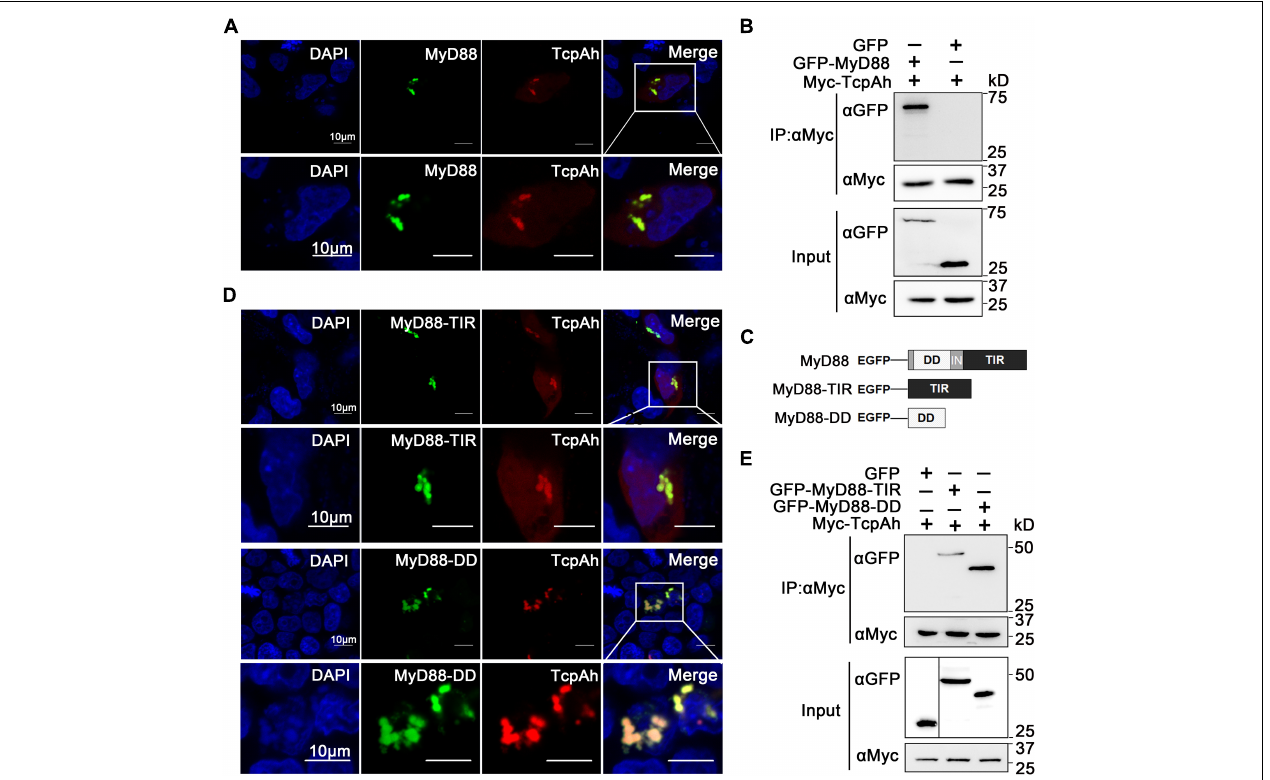
FIGURE 4 | Interaction between TcpAh and MyD88 by TIR–TIR and TIR–DD interactions. (A) Co-localization analysis of TcpAh and zebrafish MyD88 proteins in HEK293T cells by confocal microscopy (Zeiss LSM 710; original magnification, 630 × ). The nucleus was stained with DAPI. Scale bars correspond to 10 µ m. (B) Co-IP analysis between TcpAh and zebrafish MyD88 proteins from HEK293T cells expressing Myc-TcpAh with GFP or GFP-MyD88. (C) Schematic diagram of wild-type and domain-truncated zebrafish MyD88 forms. (D) Co-localization analysis between TcpAh and truncated MyD88 proteins in HEK293T cells by confocal microscopy (Zeiss LSM 710; original magnification, 630 × ). The nucleus was stained with DAPI. Scale bars correspond to 10 µ m. (E) Co-IP assay between TcpAh and MyD88-TIR domain (148–284 aa) or MyD88-DD domain (11–101 aa) as shown in (B) , except MyD88-TIR or MyD88-DD was used instead of full-length wild-type